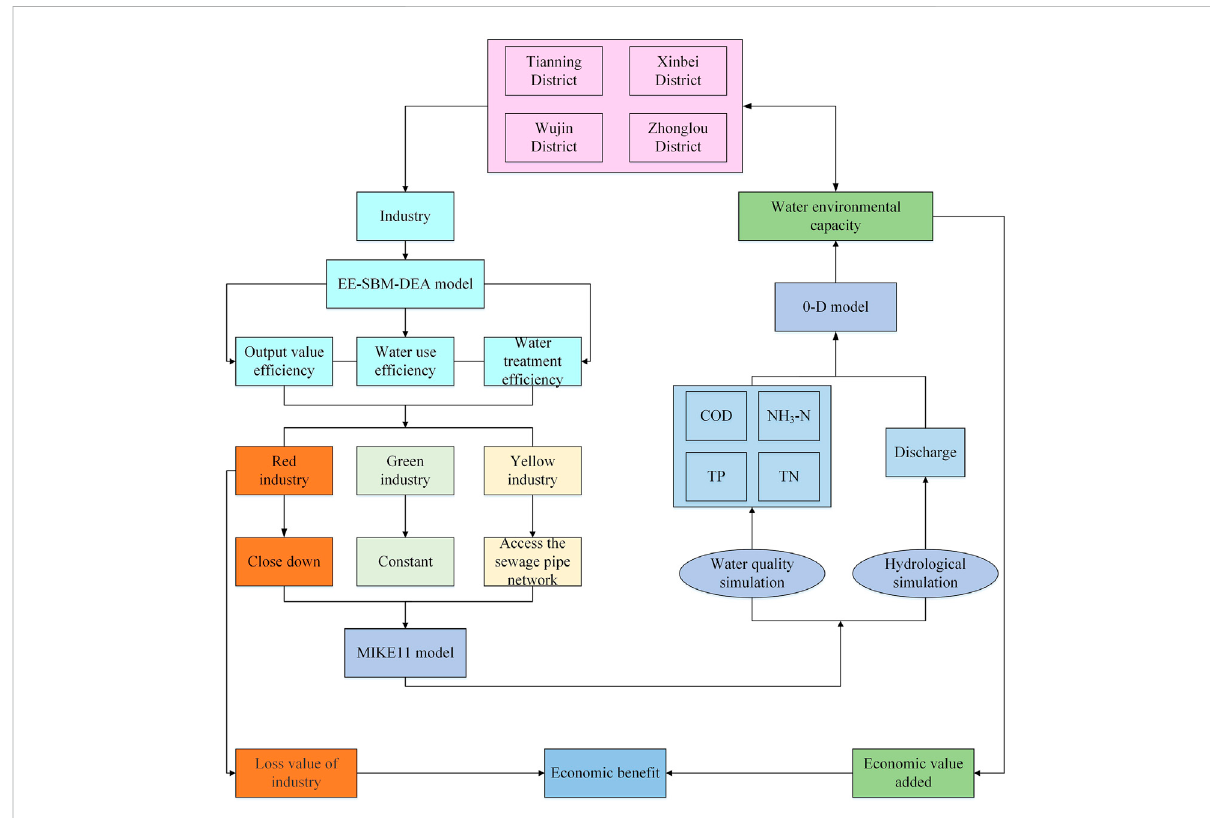
FIGURE 1 Flow chart of water environmental capacity optimization and economic bene fi t. The EE – SBM – DEA model is used to classify fi rms into three types, after different industrial types are treated with different methods, the water environmental capacity of the canal are calculated by the MIKE11 and 0-D model, then the economic bene fi ts are obtained by water environmental capacity and industrial